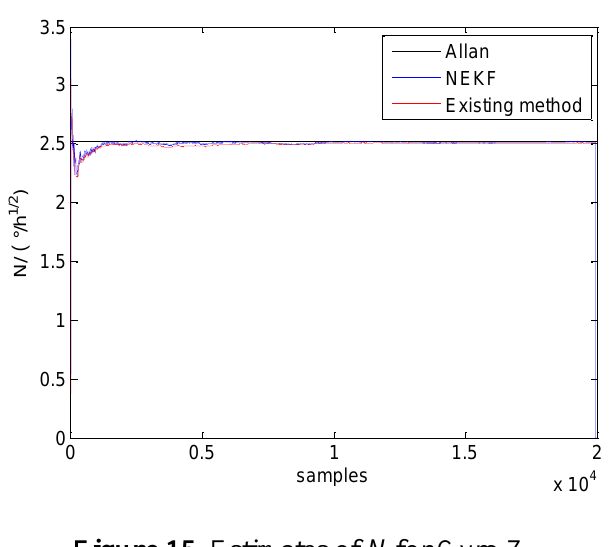
Figure 15. Estimates of N for Gyro Z.